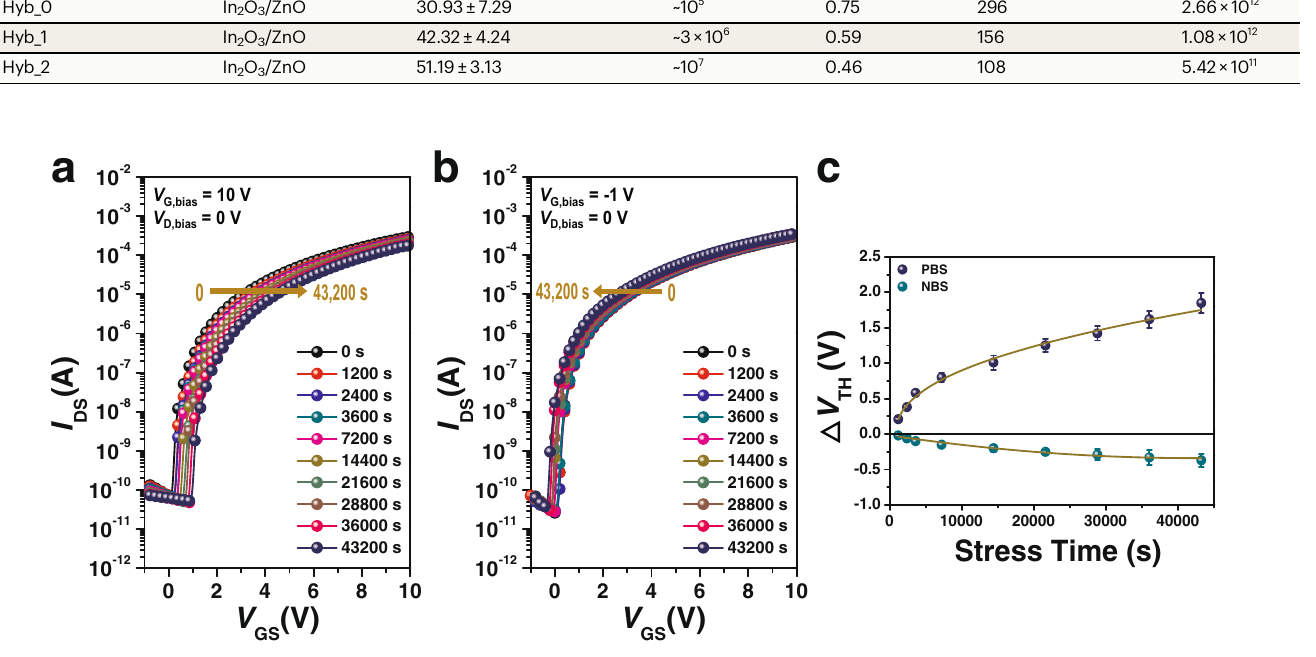
Fig. 5| Operationalbias-stressstability ofIn 2 O 3 /ZnOheterojunctionTFTswith Hyb_2 as a gate dielectric. a Transfer characteristics under PBS ( V G,bias =10V, V D,bias =0V). b Transfer characteristics under NBS (